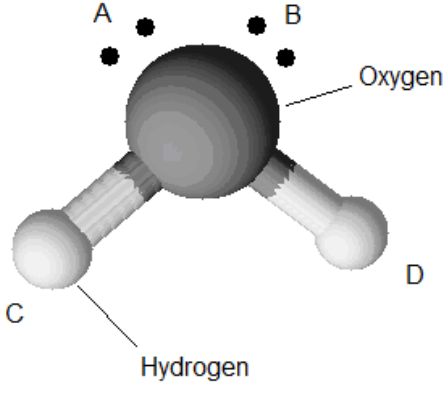
Figure 6. Association model of a water molecule